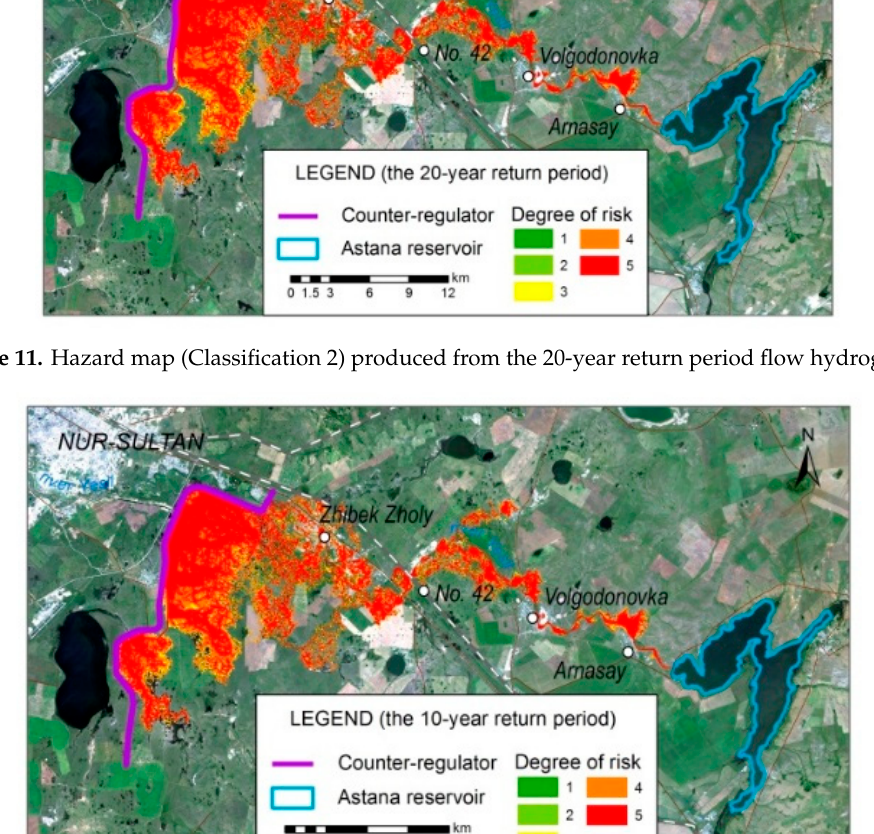
Figure 12. Hazard map (Classification 2) produced from the 10-year return period flow hydrograph. Table 9. Results of flood hazard classification (Classification 2) for each scenario.